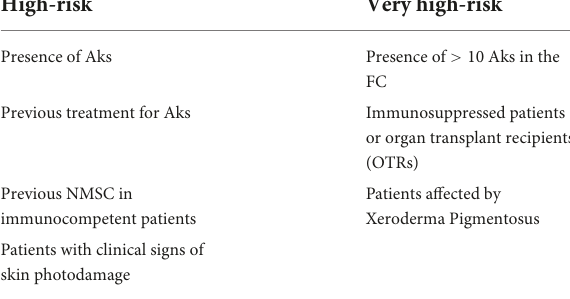
TABLE 1 Patients requiring use of sunscreens and DNA repair ingredients.